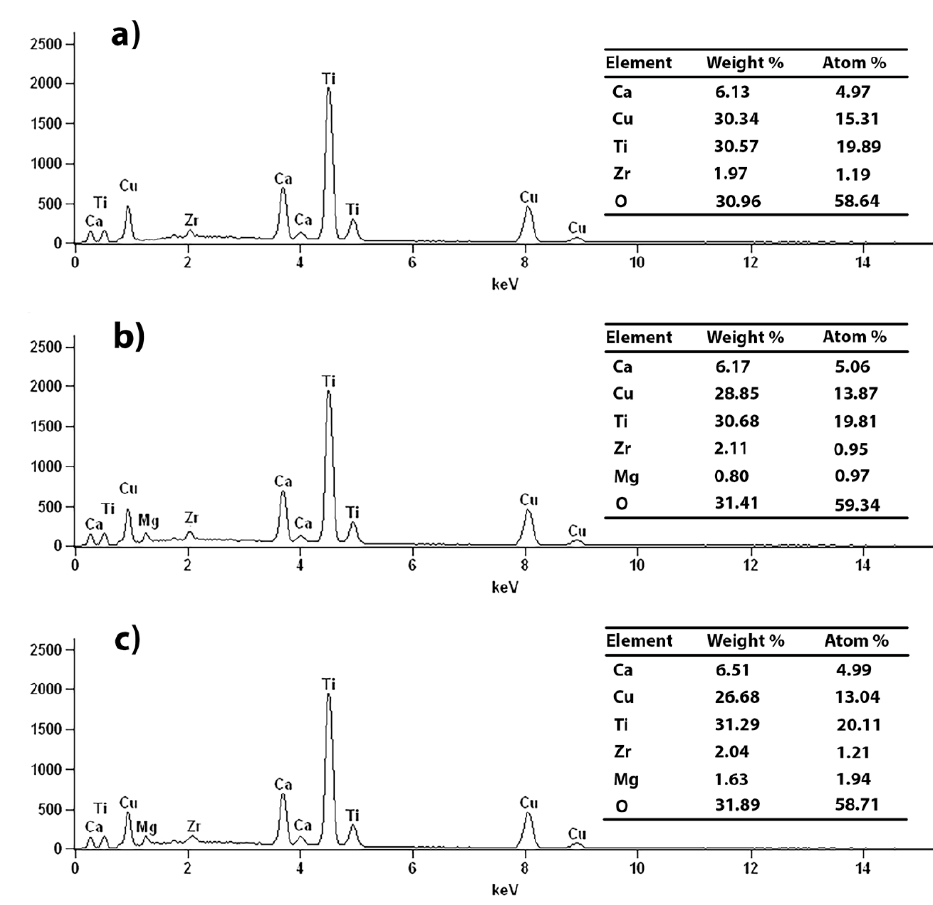
Figure 2. EDS analysis of the mechanochemically-prepared samples: ( a ) CaCu 3 Ti 4 O 12 ; ( b ) Figure 2. ( a ) CaCu 3 Ti 4 O 12 ; CaCu 2.8 Mg 0.2 Ti 4 O 12 ; ( c ) CaCu 2.6 Mg 0.4 Ti 4 O 12 . ( b ) CaCu 2.8 Mg 0.2 Ti 4 O 12 ; ( c ) CaCu 2.6 Mg 0.4 Ti 4 O 12